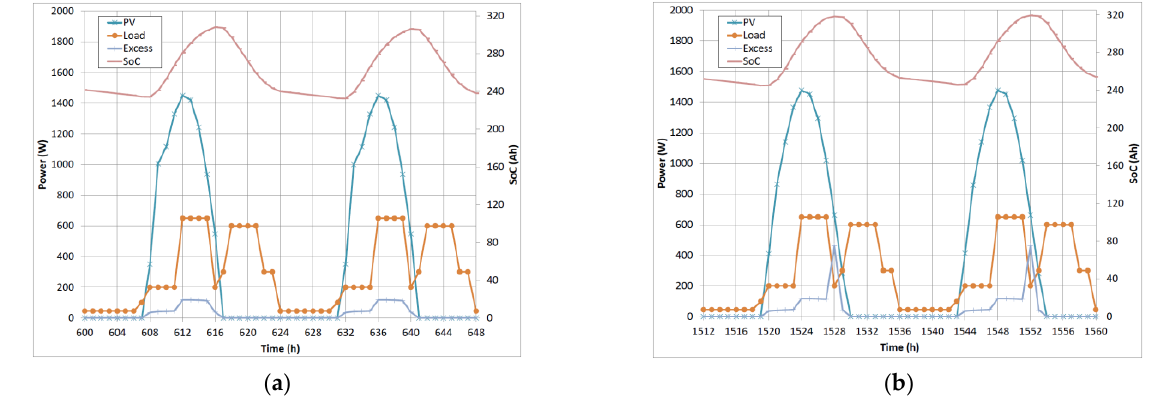
Figure 7. Results of analysis of the case with a 450 W additional load: ( a ) 24 – 25 July and ( b ) 5 – 6 March.